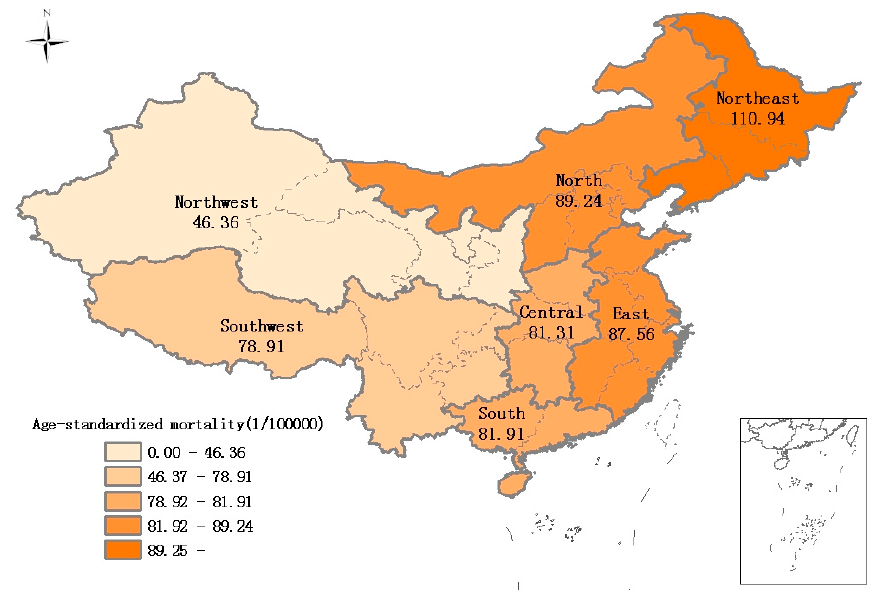
Figure 2. Distribution of age-standardized mortality of lung cancer in China.